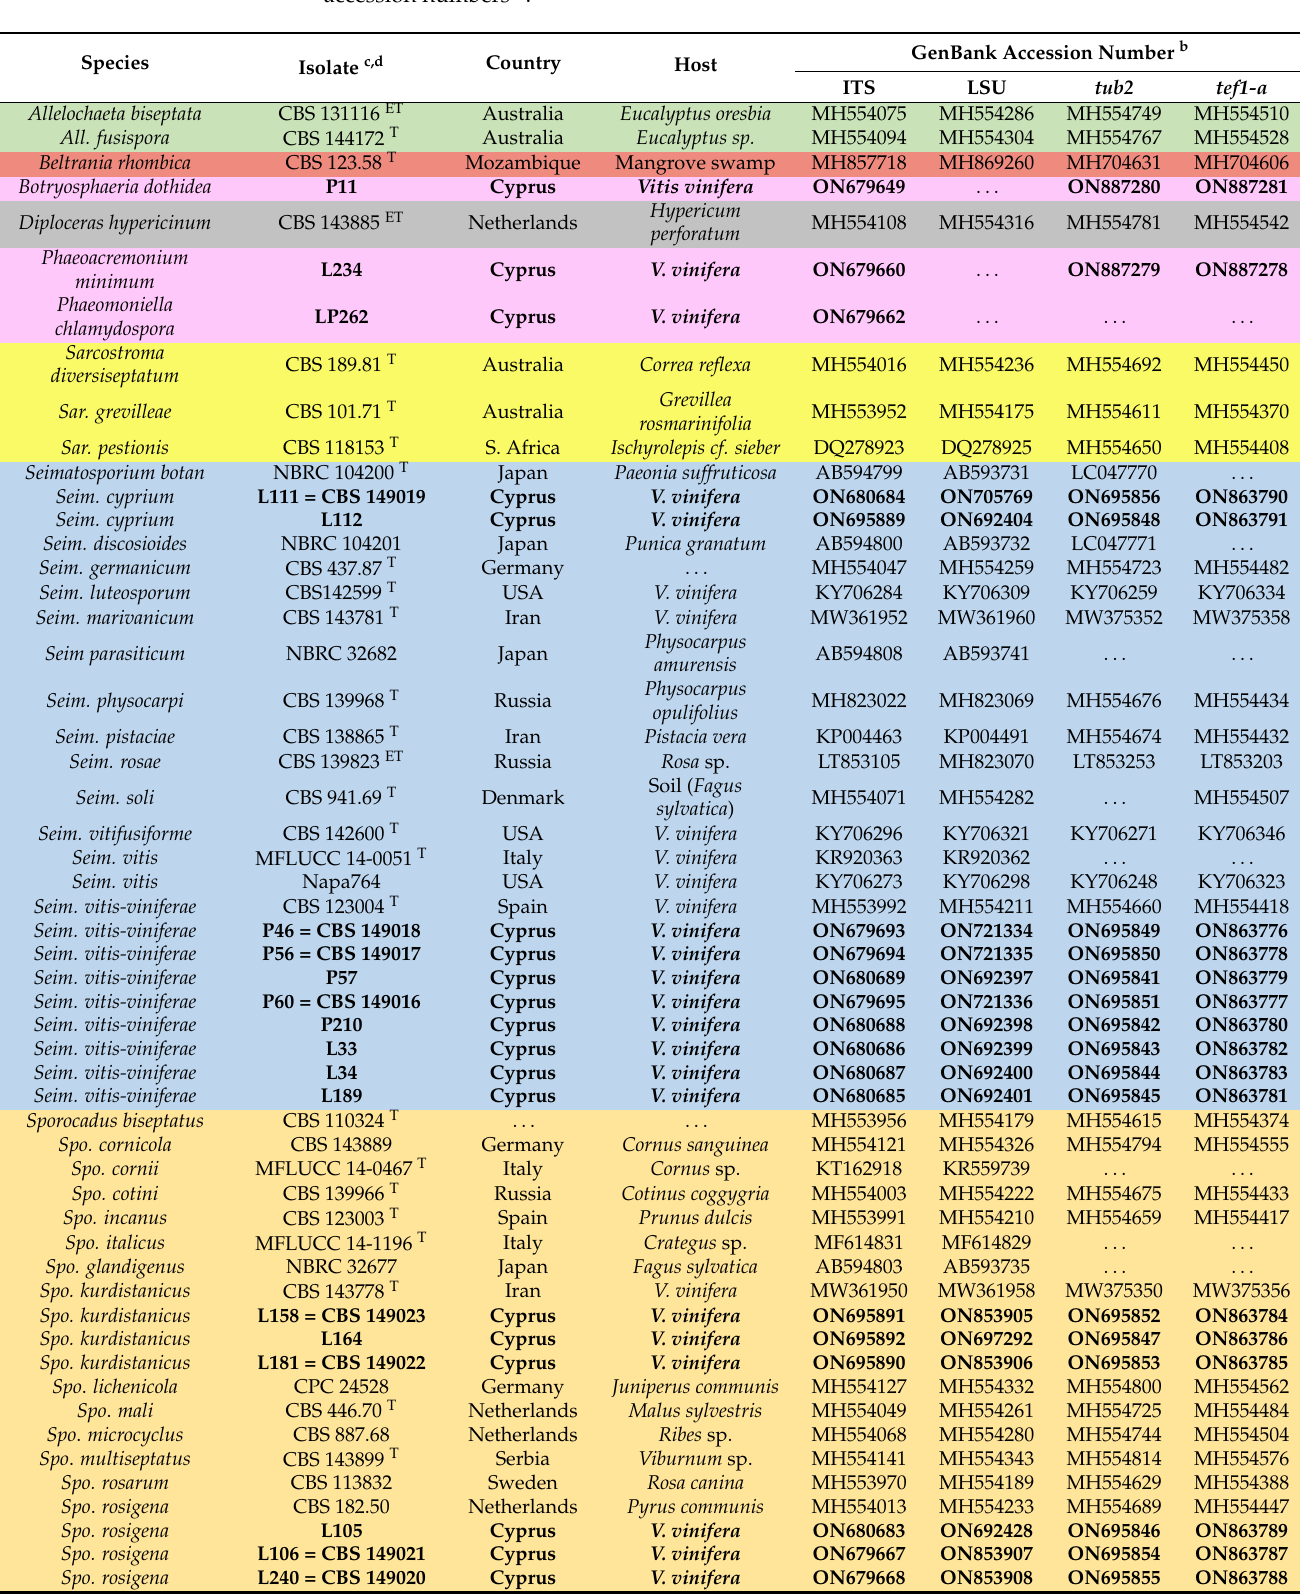
Table 3. Isolates used in this study with details regarding their geographic origin, host, and GenBank accession numbers a